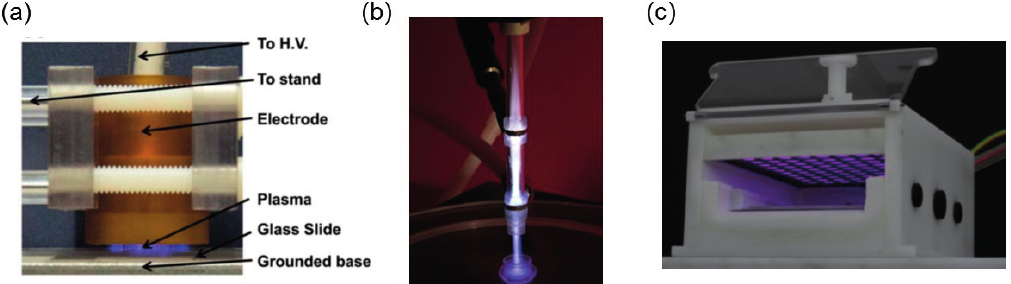
Figure 1. Photograph of various Atmospheric Pressure Plasma (APP) sources in operation: ( a ) a direct floating electrode-dielectric barrier discharge (FE-DBD) in ambient air (adapted from [7], 2011); ( b ) an indirect APP jet (APPJ) ignited in helium (adapted from [45] with permission from Elsevier, Inc., 2014); and ( c ) a hybrid FlatPlaSter in ambient air (reprinted from [15] with permission from Elsevier, Inc., 2013).